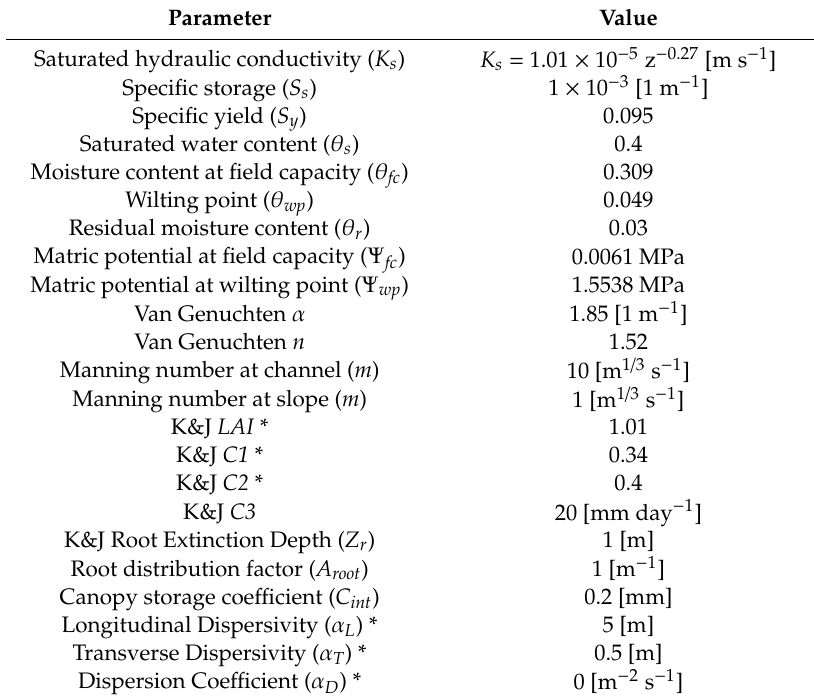
Table 1. Main parameters characterizing the soil, surface flow, transpiration (K&J stands for Kristensen and Jensen, 1975), and salt